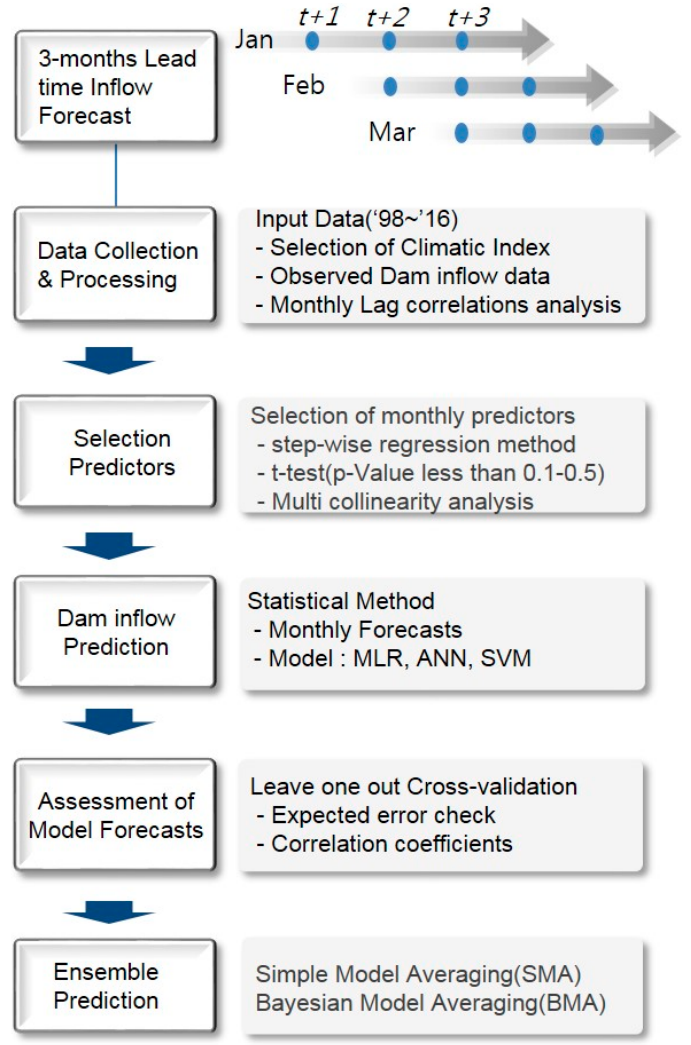
Figure 4. Flowchart of small basin scale dam inflow prediction by multiple linear regression (MLR), a support vector machine (SVM) and ANN.